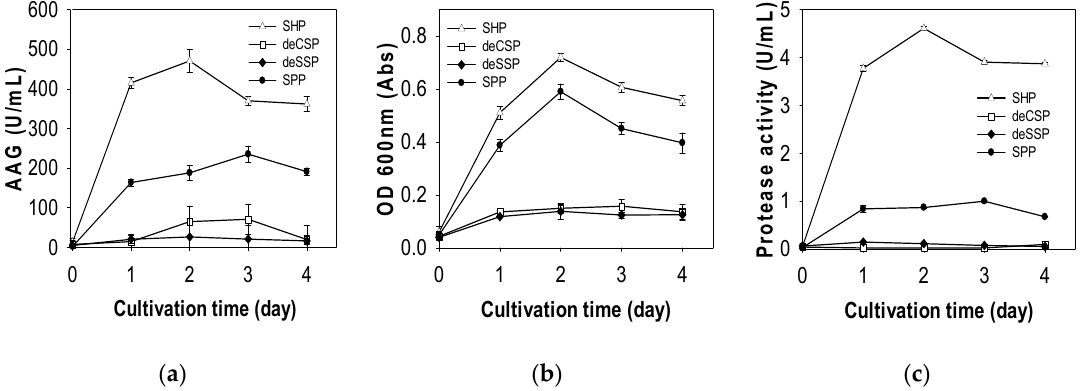
Figure 7. Effect of the C/N source on AAG ( a ), optical density (OD) ( b ) and protease activity production ( c ) of B. licheniformis TKU004.